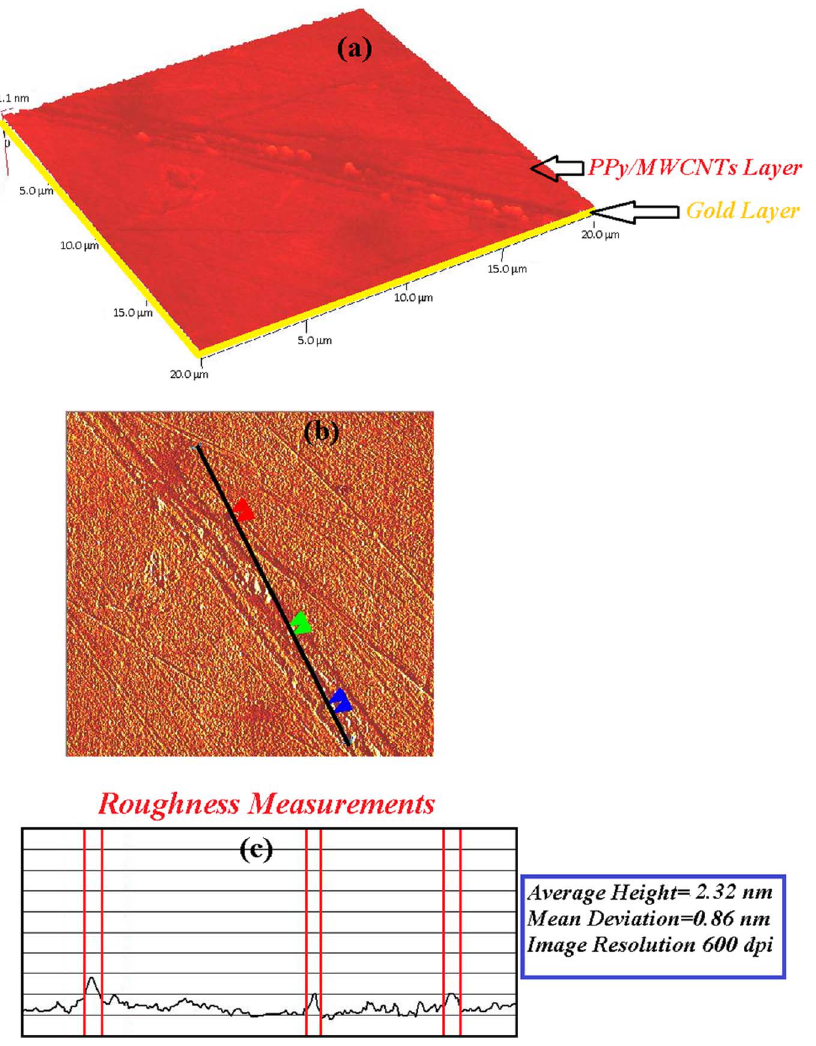
Figure 12. The AFM image for PPy-MWCNTs before the adsorption of the Hg ion. The roughness of layer was about 2.32 nm.